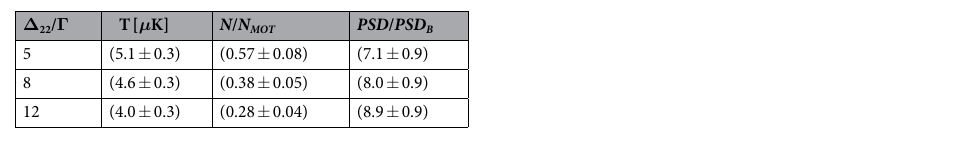
Table 1. Minimum temperature T , fraction of remaining atoms N / N MOT and normalized phase space density PSD / PSD B measured for δ R = − 0.01 Γ